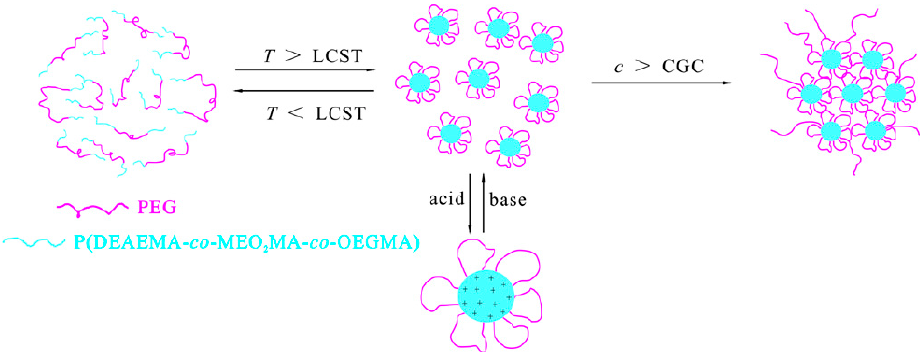
Scheme 2. Micellization and gelation process of the ABA triblock copolymer.